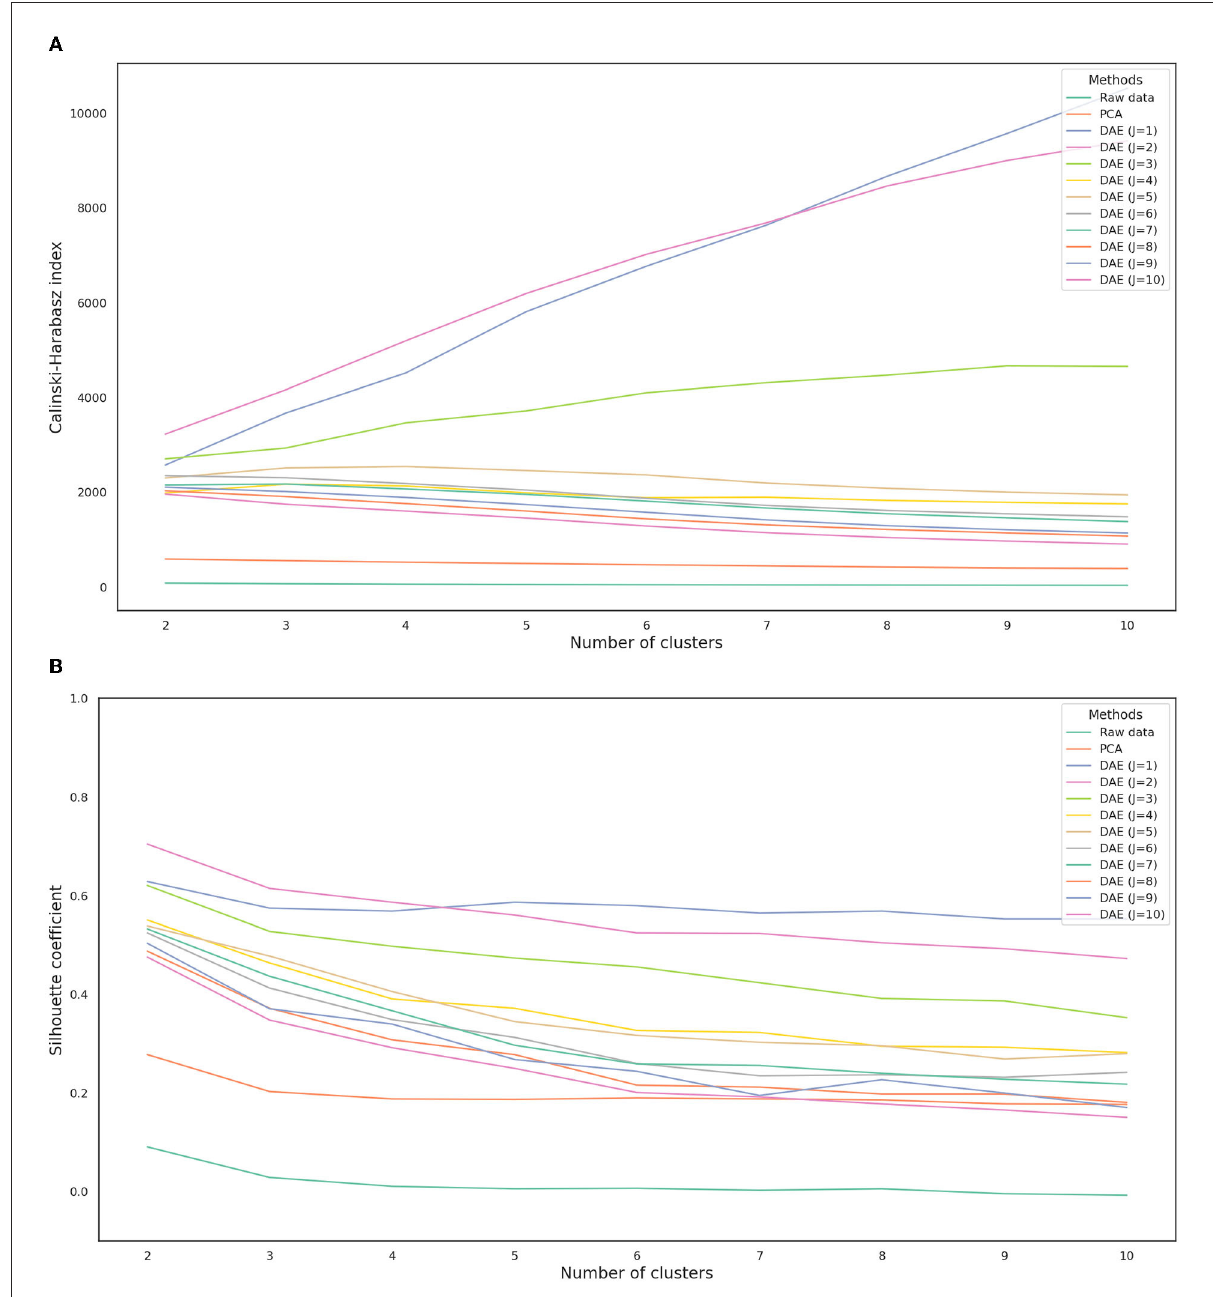
FIGURE4 Calinski-Harabasz index (A) and silhouette coefficient (B) depending on each feature extraction method . J is the number of nodes in the second hidden layer. DAE, deep autoencoder; PCA, principal component analysis.